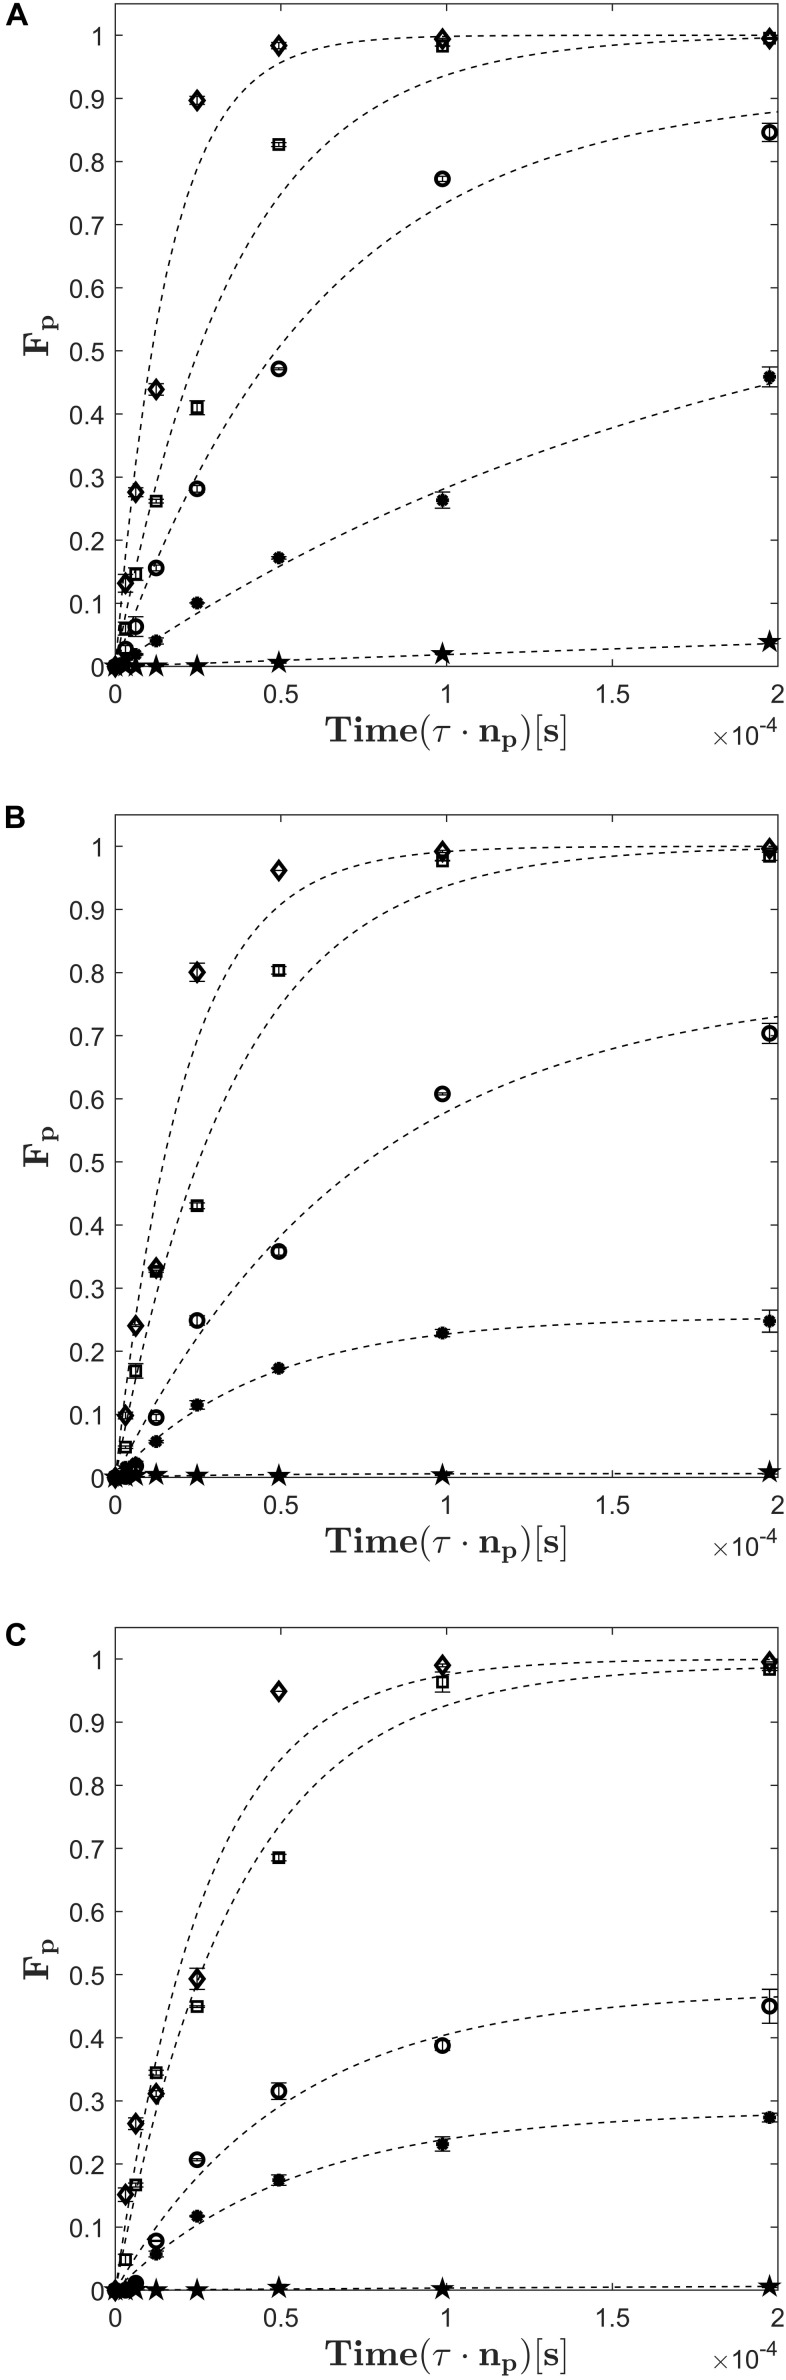
Fraction of perforated cells (Fp) as a function of electric field strength, treatment time and treatment temperature (A: 40°C, B: 30°C, C: 20°C). The electric field strength is indicated by different symbols: 6.5kVcm−1 (stars), 9kVcm−1 (filled circles), 13.5kVcm−1 (empty circles), 20kVcm−1 (squares), 27kVcm−1 (diamonds). Error bars indicate the standard deviation. The dashed lines are best fits obtained with equation (9).